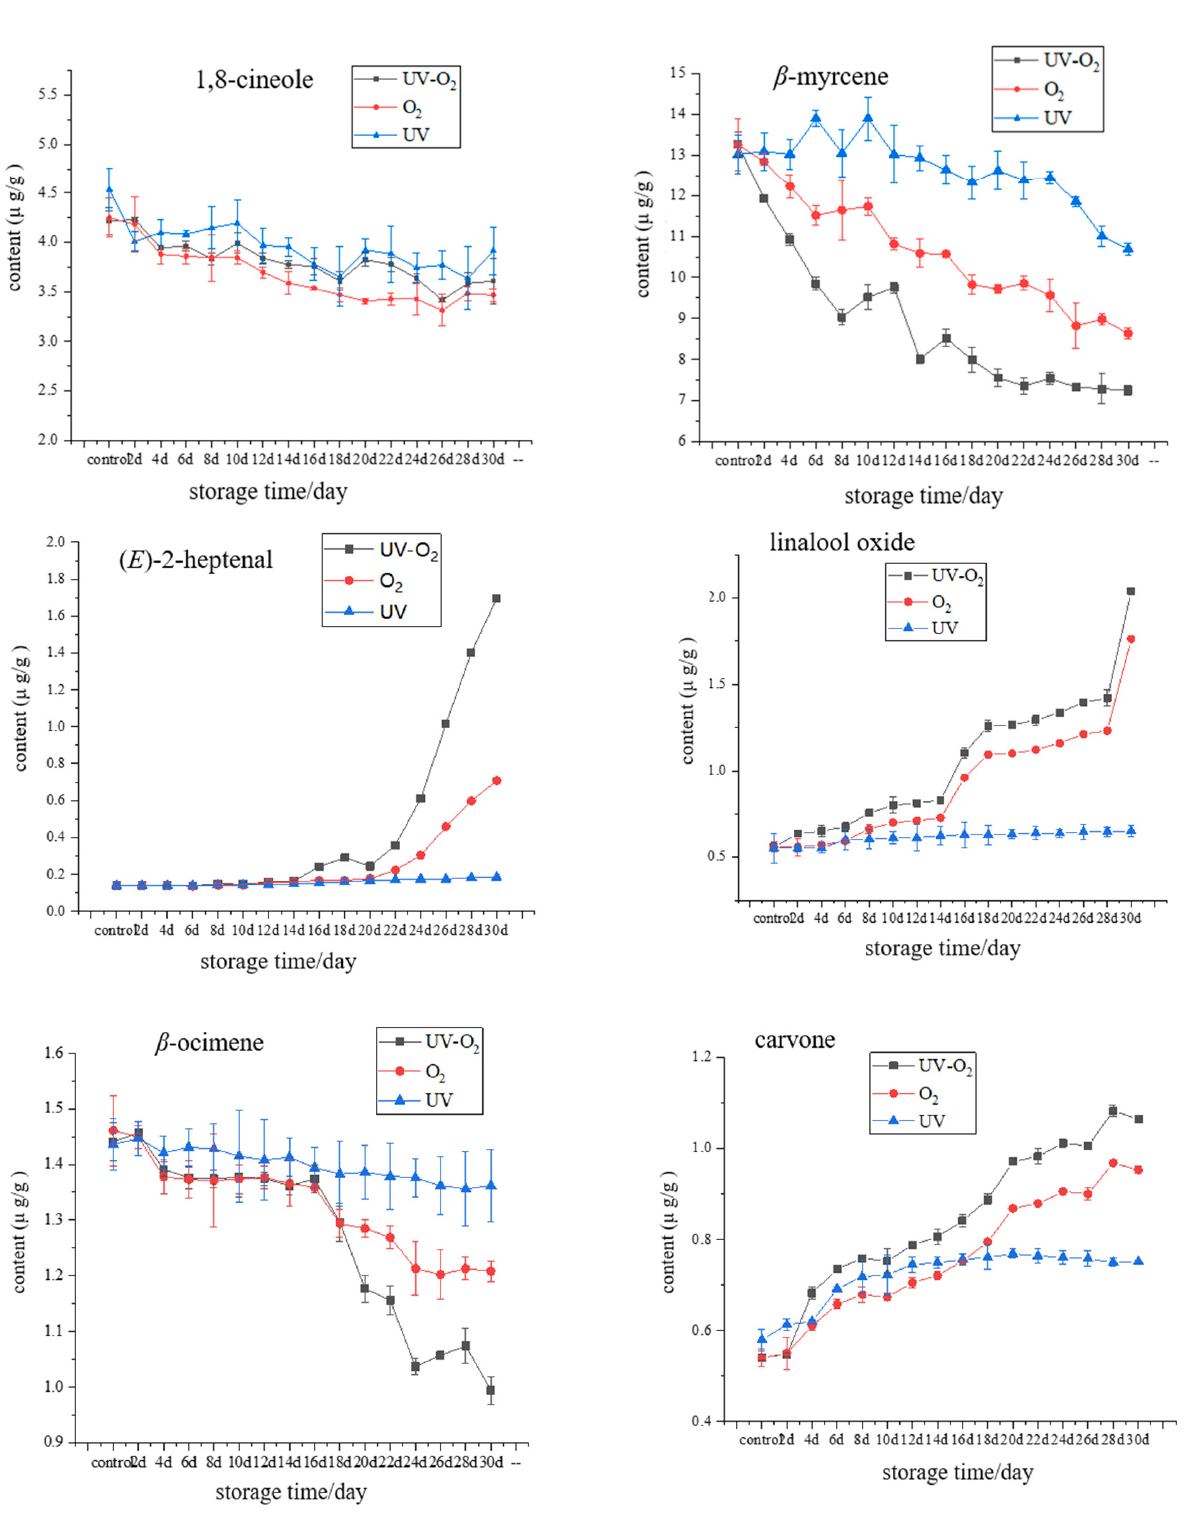
Figure 2. Variation of key aroma compounds in fried pepper oil under different storage conditions.